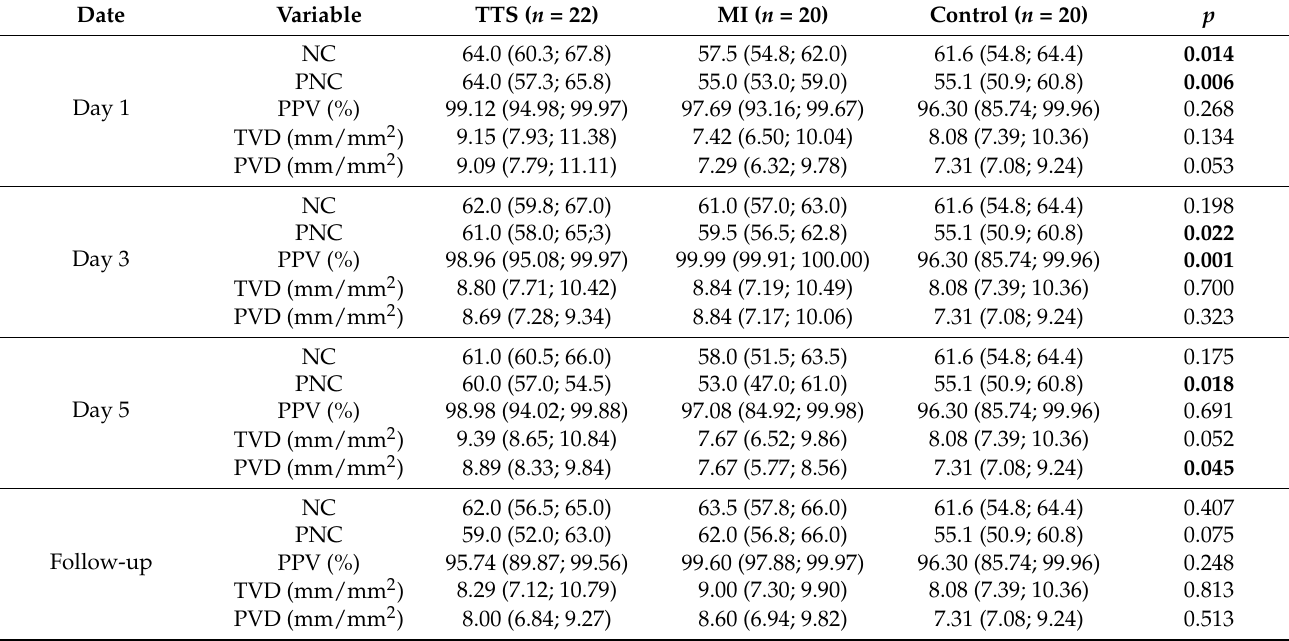
Table 2. Results of microcirculation